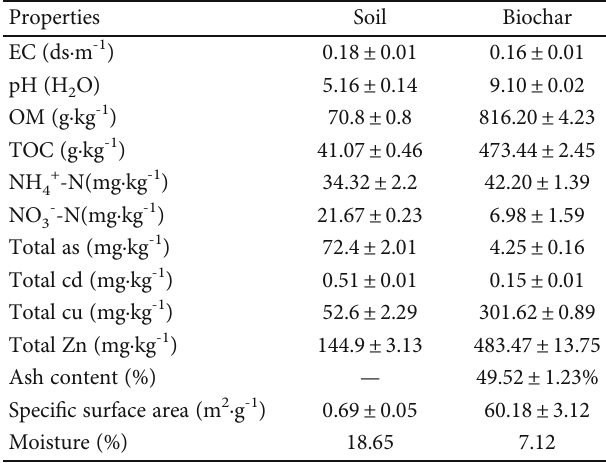
Table 1: Physicochemical properties of experimental soil and